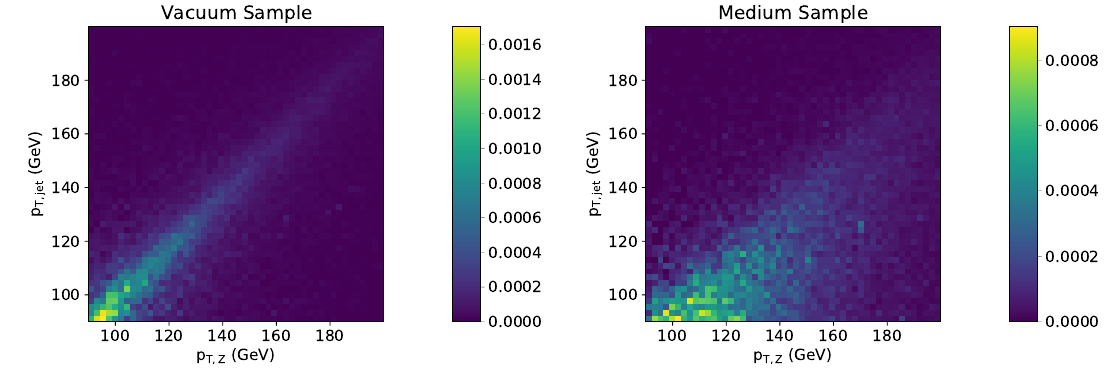
Figure 3 . Bi-dimensional distributions of the Z -boson and jet transverse momenta, p T,Z and p T, jet , for the JEWEL+PYTHIA (left) Vacuum and (right) Medium